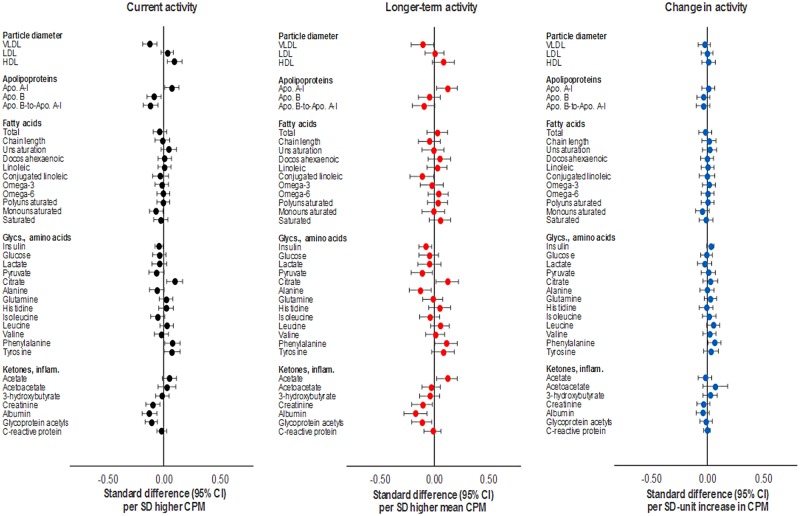
Associations of total activity (CPM) with lipoprotein particle diameter, apolipoproteins, fatty acids, glycolysis factors, amino acids, ketones, and inflammatory factors at age 15y in ALSPAC.Metabolic traits are in standardised units. Current activity defined as measure at age 15y. Longer-term activity defined as mean of 3 measures (at age 12y, 14y, and 15y). Change in activity defined as difference between measures at age 12y and 15y. Models are adjusted for age, sex, ethnicity, maternal education, device wear time and wear month, smoking and alcohol (for current activity), and fat mass index (based on current, mean, or change values) across measures at age 12y, 14y, and 15y. ALSPAC, Avon Longitudinal Study of Parents and Children; CPM, counts per minute.